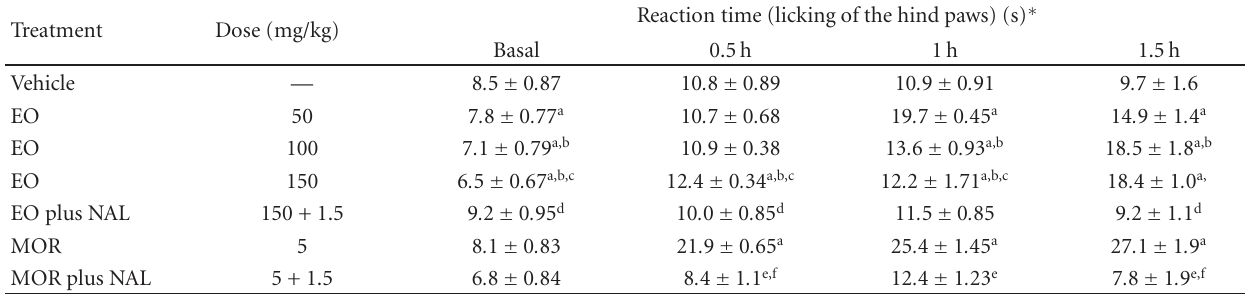
Table 3: E ff ects of essential oil (EO) of Citrus limon or morphine (MOR) on the hot plate test in the absence and presence of naloxone in